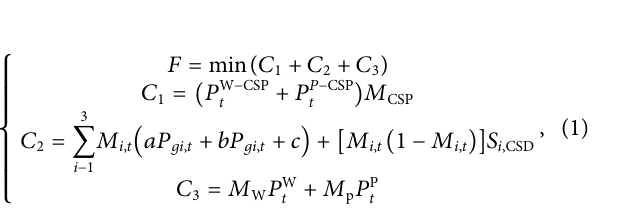
Frontiers in Energy Research |